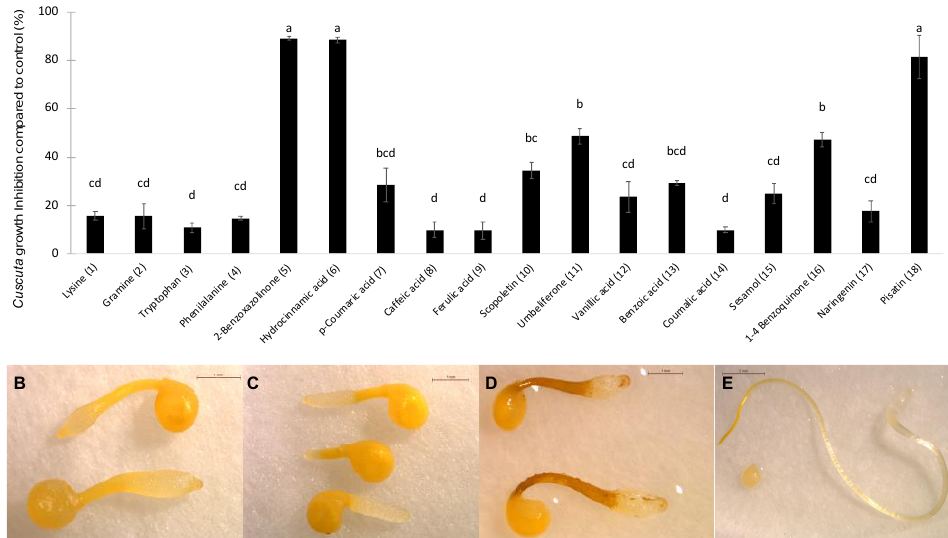
Figure 3. Inhibition of Cuscuta growth observed in the first screening ( A ). Illustrative photographs showing the growth inhibition observed in 1 mM treatments of ( B ) 2-benzoxazolinone ( 5 ), ( C ) hydrocinnamic acid ( 6 ) and ( D ) pisatin ( 18 ) in comparison with ( E ) Cuscuta seedlings treated with control. In ( A ), bars with different letters are significantly different (Tukey test at p < 0.05). Error bars represent the standard error of the mean.